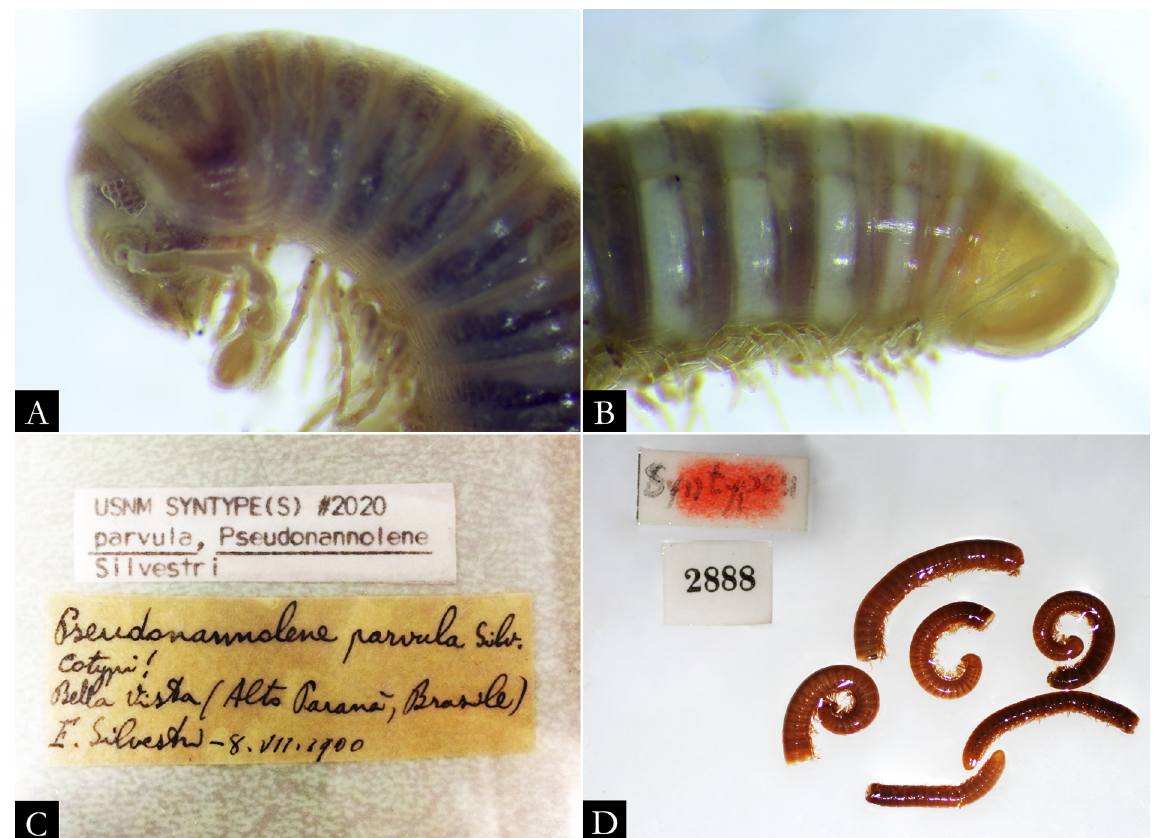
Fig. 105. Pseudonannolene parvula Silvestri, 1902, ♀ syntype (USNM 2020). A . Anterior region. B . Posterior region. C . Original label of type material. D . Body of syntypes (ZMB 2888), in lateral view. Images not to scale.